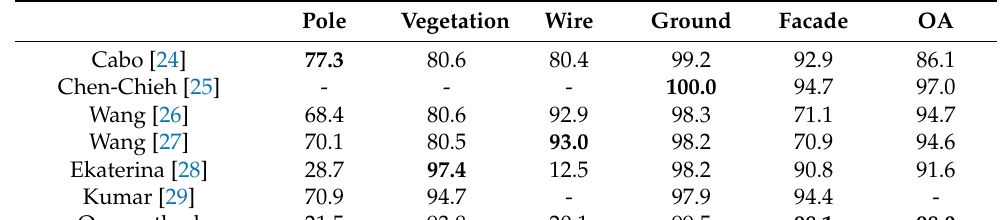
Table 3. Comparison accuracy of Oakland dataset (%).